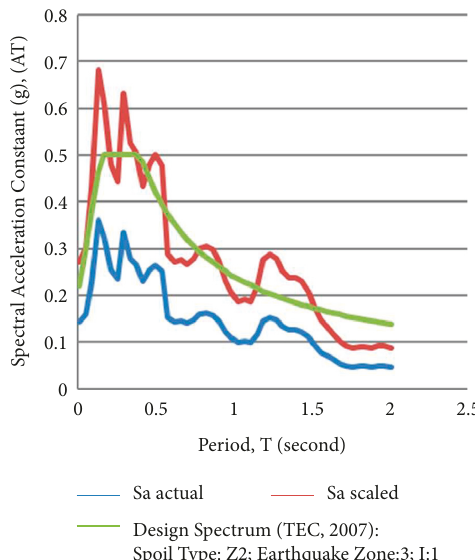
Figure 10: Earthquake with an epicenter at Kayseri-Kocasinan ( M according to elastic design acceleration spectrum.